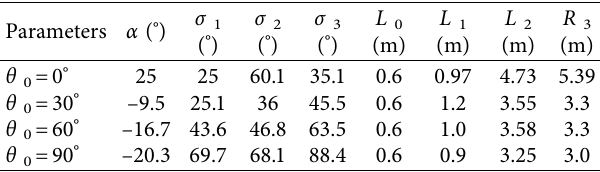
Table 2: Te variable values of the corresponding tri-refector CATR for four diferent feed rotation